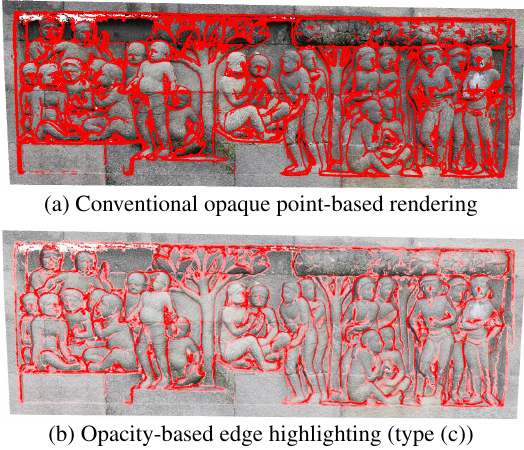
(b) Opacity-based edge highlighting (type (c)) Figure 14. Comparative visualizations of the Borobudur relief (1): Highlighting outlines of human characters in the relief.